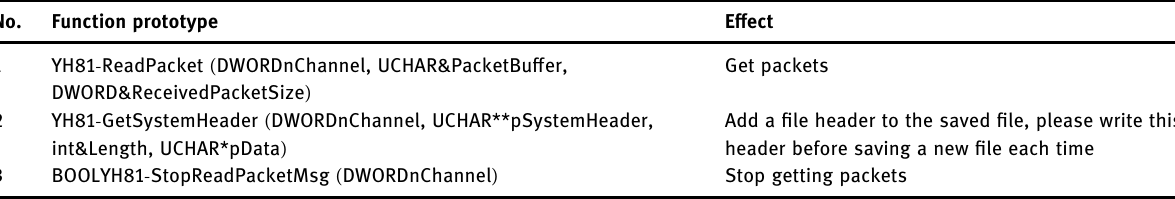
Table 6: Video storage functions No. Function